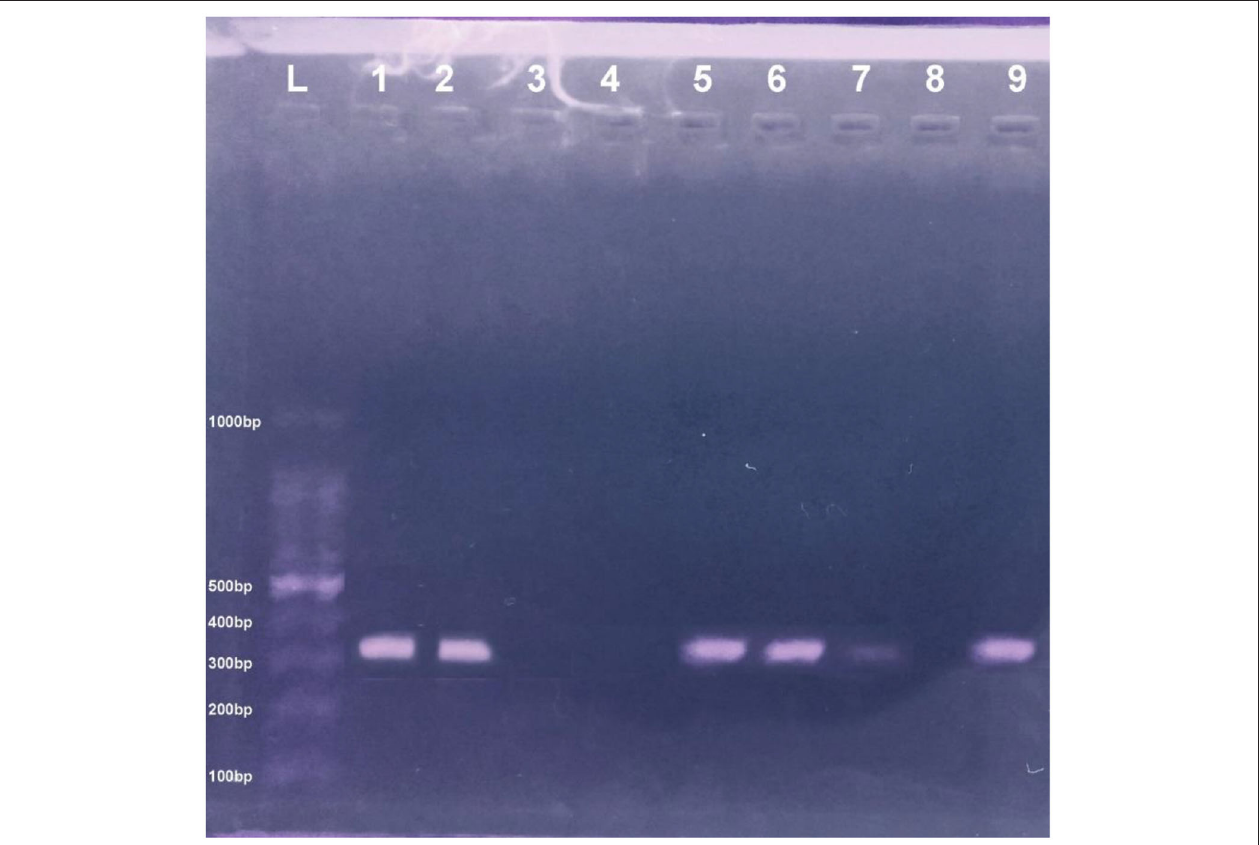
FIGURE 2 | PCR pic of mecA gene at 310 bp. Lane L showing the ladder DNA, where Lane 8 and 9 are negative and positive control, respectively, and Lane 1–2 and 5–7 show mecA positive samples while Lane 3–4 express negative mecA isolates.